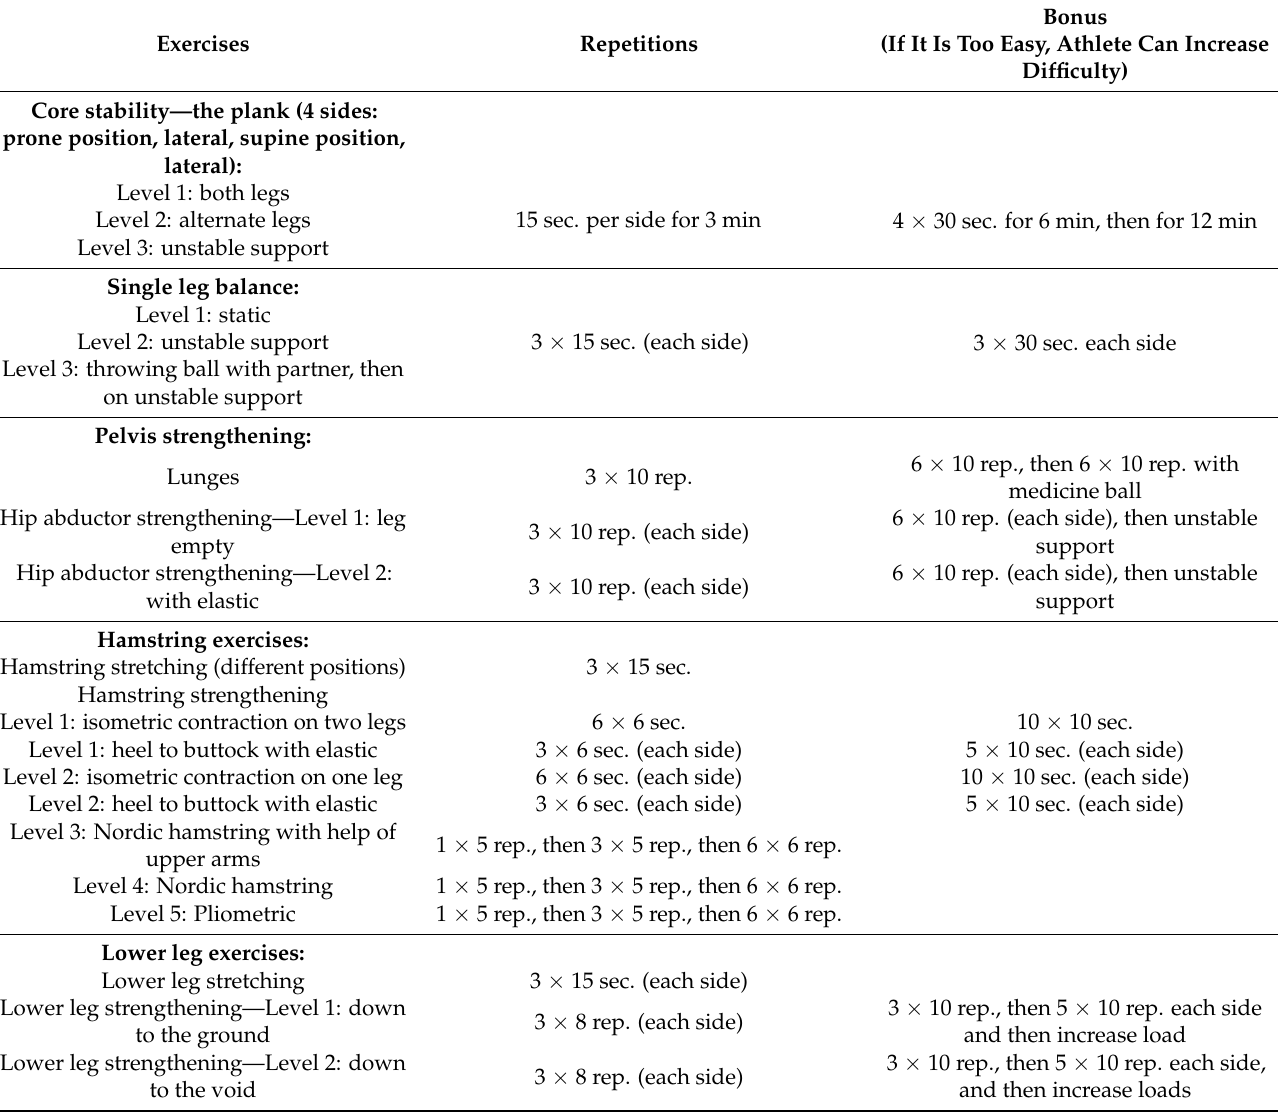
Table 1. Content and structure of the Athletics Injury Prevention